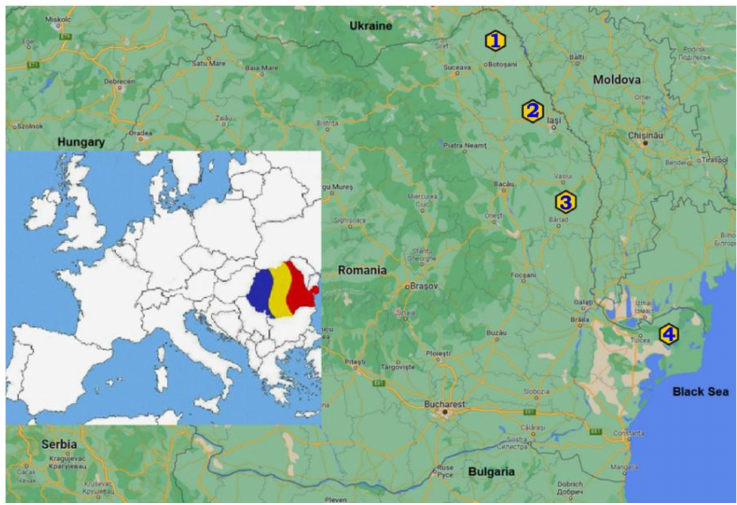
Figure 1. Geographic regions of collected honey samples (1—Botosani County; 2—Iasi County; 3—Vaslui County; 4—Tulcea